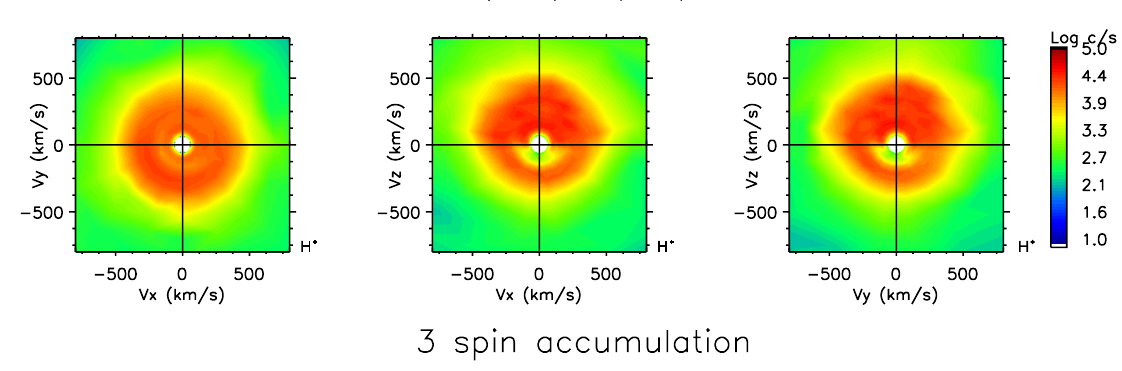
Fig. 36. H + ions 3D CODIF measurement on spacecraft 3 on 19 February 2001, at 01:18:30UT.